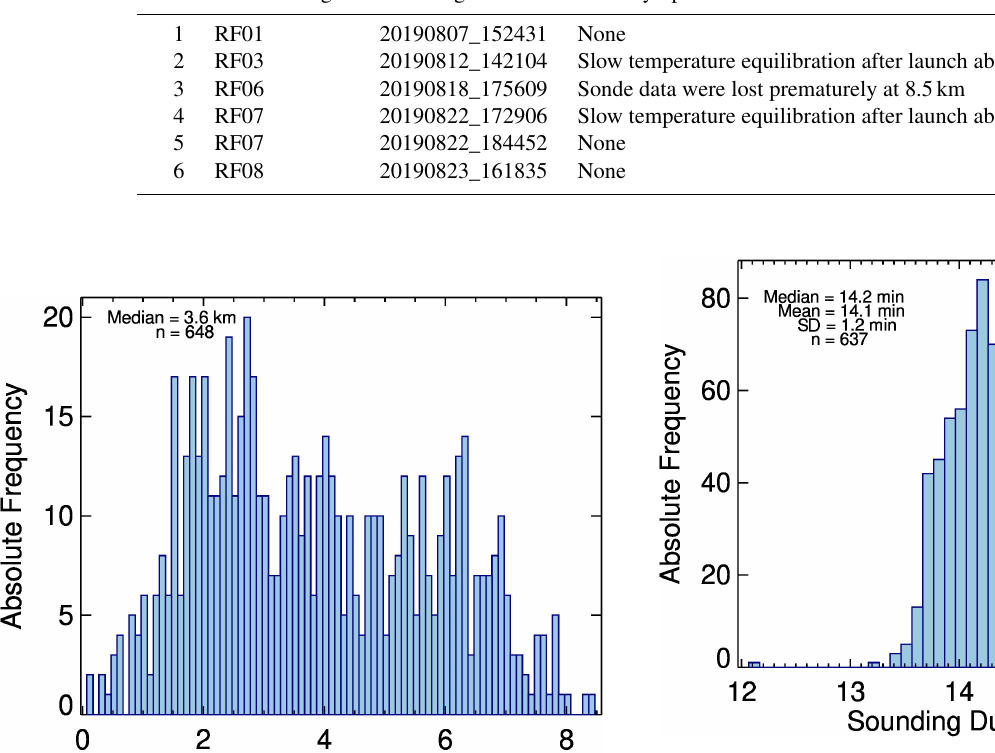
Figure 8. Measurement duration for all dropsonde with normal parachute behavior reaching the